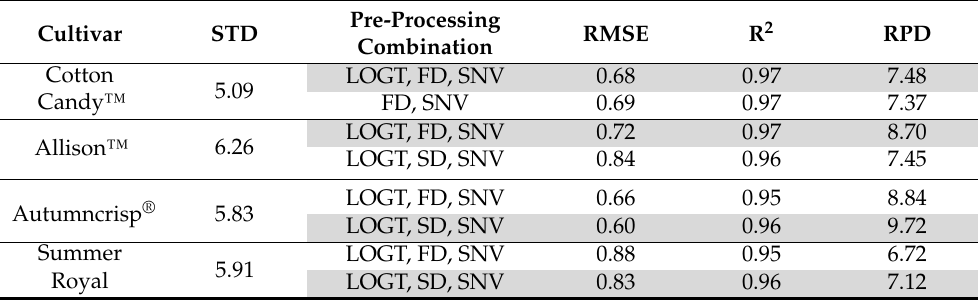
Table 4. PLSR accuracy for each cultivar by means of the best combinations of pre-processing techniques in the season 2020. In grey background the best pre-processing combinations. Pre-Processing Cultivar STD RMSE R 2 RPD Combination